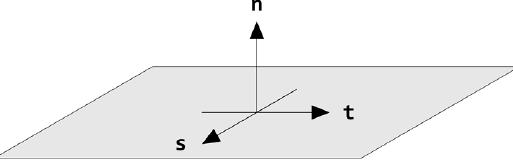
Figure 8. Directions interface for Contact Cohesive Behavior in ABAQUS.